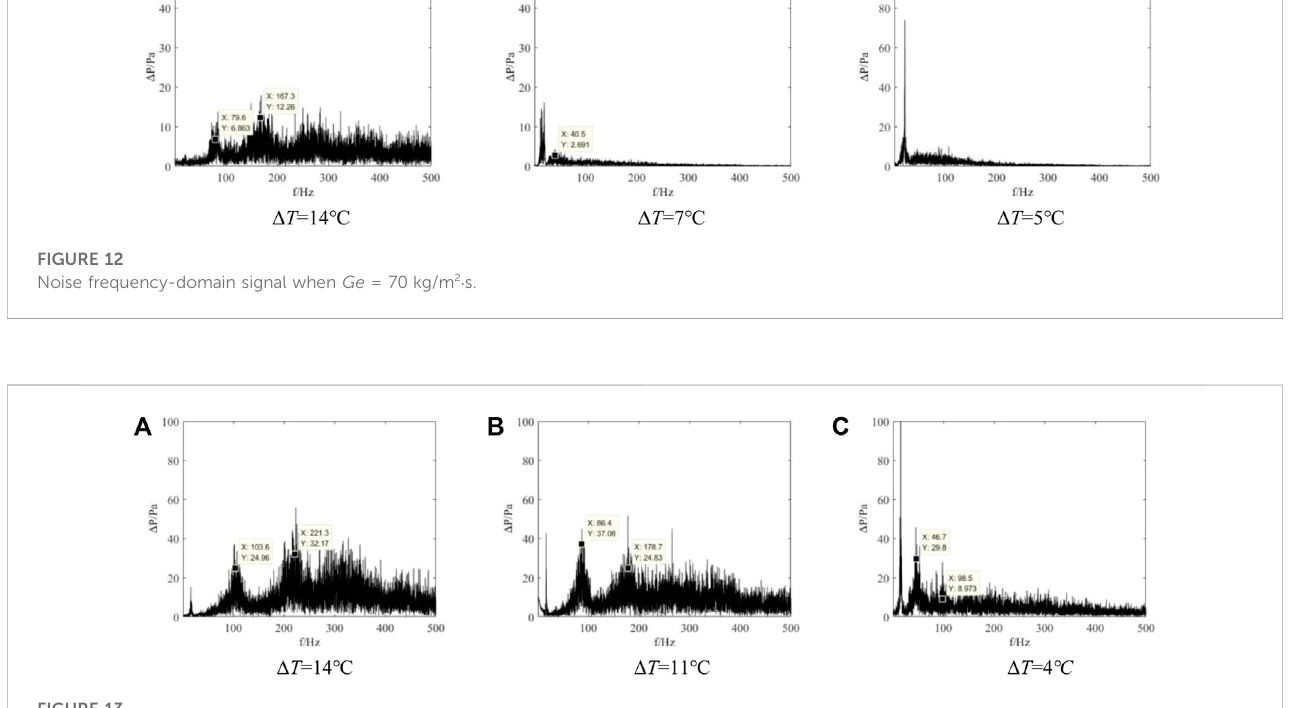
frequency fi rst increases and then decreases with the increase in steam fl ow. At this time, the main frequency of noise may be turbulent noise.